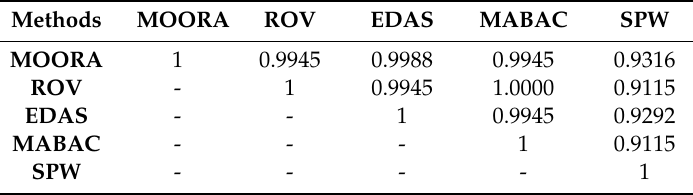
Table 10. Spearman’s rank correlation coe ffi cients—the second